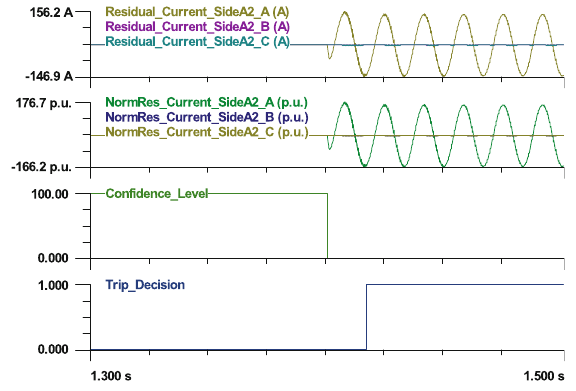
Fig. 19 EBP relay performance of event 4: internal bolted fault, islanded